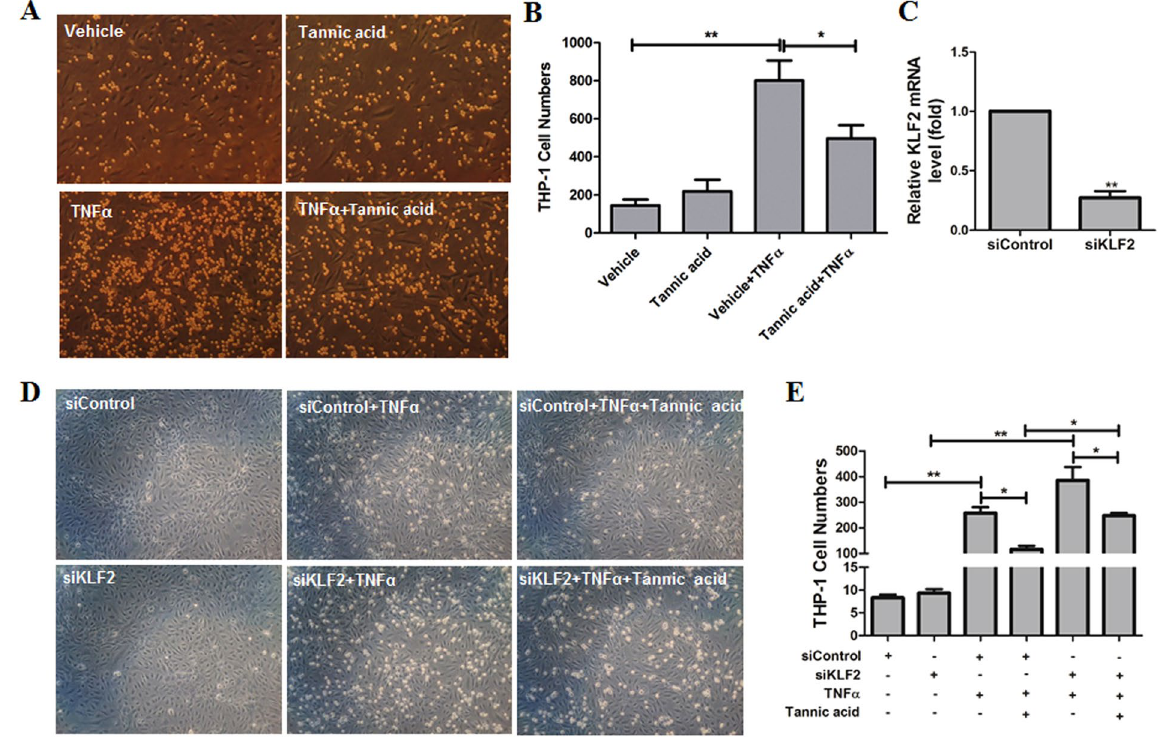
Figure 4. TA attenuated monocyte adhesion to ECs. ( A , B ) HCAECs were pretreated with vehicle (DMSO) or TA (10.0 µ M) for 12 h, and then exposed to TNF α (10 ng/ml) or vehicle (PBS) for an additional 6 h. Then, THP-1 monocytes were added for 30 min. ( A ) Images were taken from representative optical fields showing endothelial cells (cobblestone shape) and adhering THP-1 monocytes (small, round cells) in the co-culture. ( B ) THP-1 cells in panel A were counted and statistically analyzed. * p < 0.05, ** p < 0.01, n = 4. ( C – E ) HUVECs were transfected with siRNA (control siRNA) or siKLF2 (KLF2 siRNA) for 48 h. Then the cells were pretreated vehicle (DMSO) or TA (10.0 µ M) for 12 h, and then exposed to TNF α (10 ng/ml) or vehicle (PBS) for an additional 6 h. Then, THP-1 monocytes were added for 30 min. ( C ) The levels of KLF2 mRNA in ECs treated with control siRNA and KLF2 siRNA were analyzed by q-PCR. ( D ) Images were taken from representative optical fields showing endothelial cells (cobblestone shape) and adhering THP-1 monocytes (small, round cells) in the co-culture. ( E ) THP-1 cells in panel C were counted and statistically analyzed. One way ANOVA was used to analyze the data. * p < 0.05, ** p < 0.01, n =